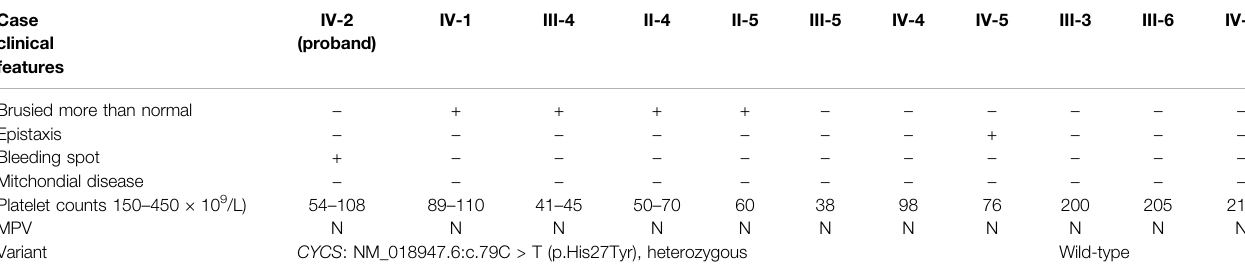
TABLE 1 | Clinical features of the family members from the current